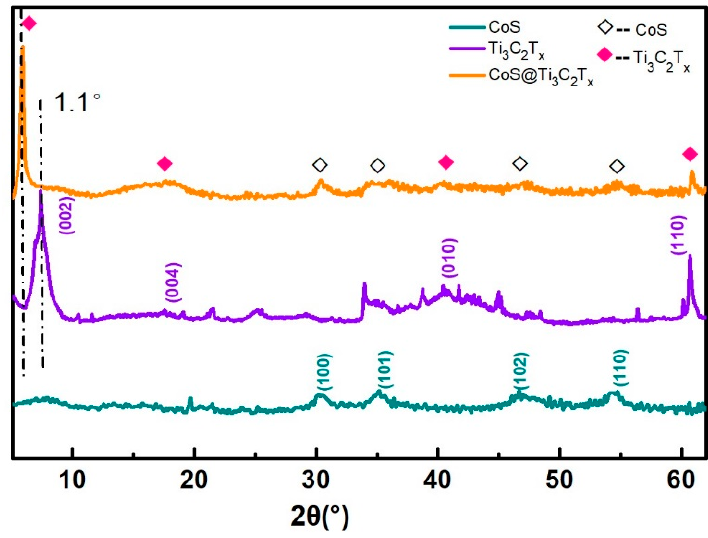
Figure 2. XRD patterns of CoS, MXene, and CoS@Ti 3 C 2 T x .